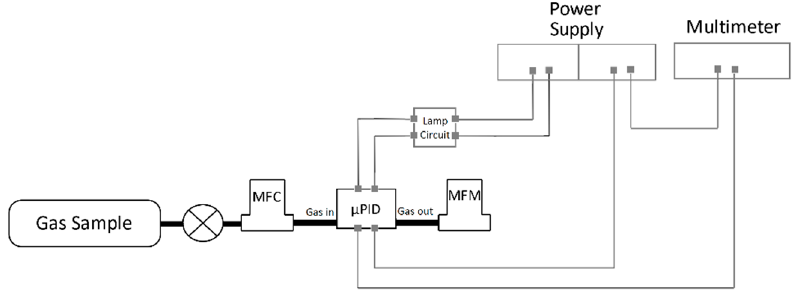
Figure 6. Experimental setup used for signal measurements from µPID prototype.